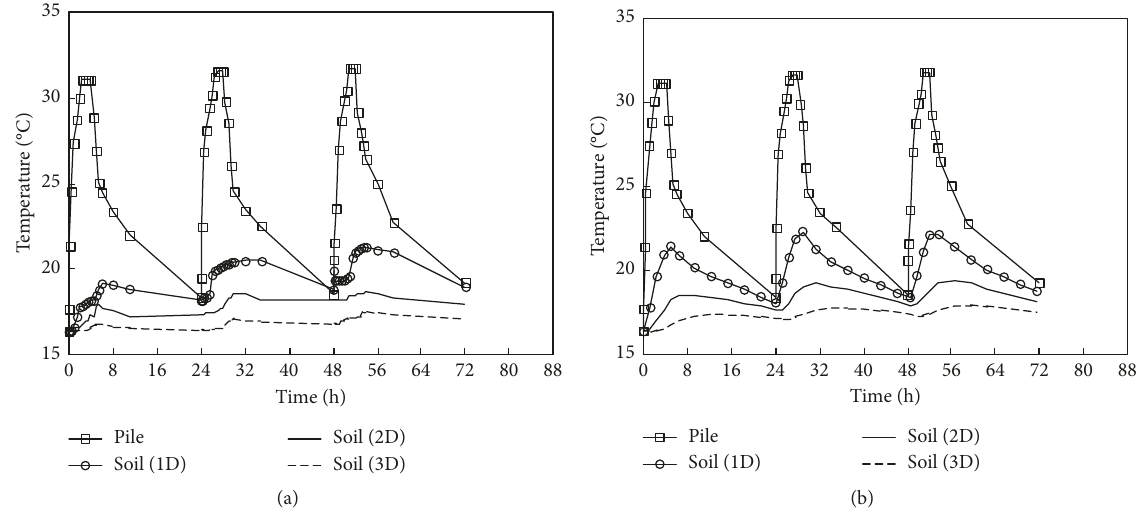
Figure 5: Temperature variation. (a) Measured. (b)